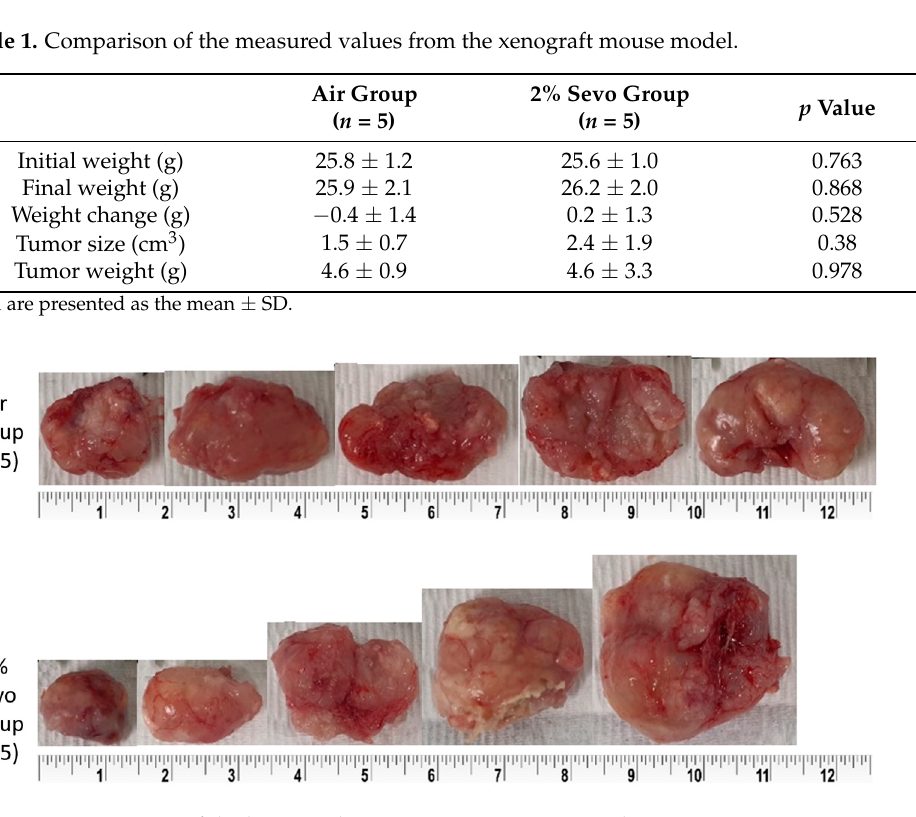
Figure 5. Comparison of the harvested tumor size in Air group and 2% Sevo group. Table 1. Comparison of the measured values from the xenograft mouse model.